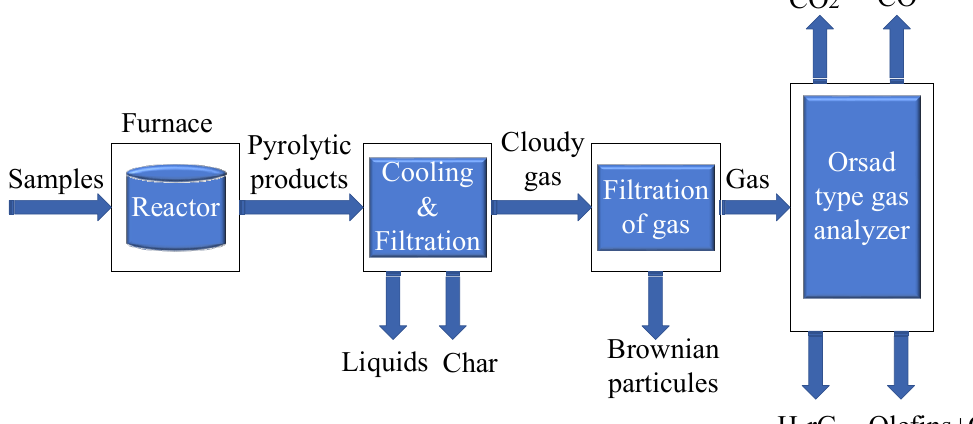
Figure 2. Pyrolysis process with hydrogen gas extraction. Table 2. Artificial neural network I/P & O/P parameters.